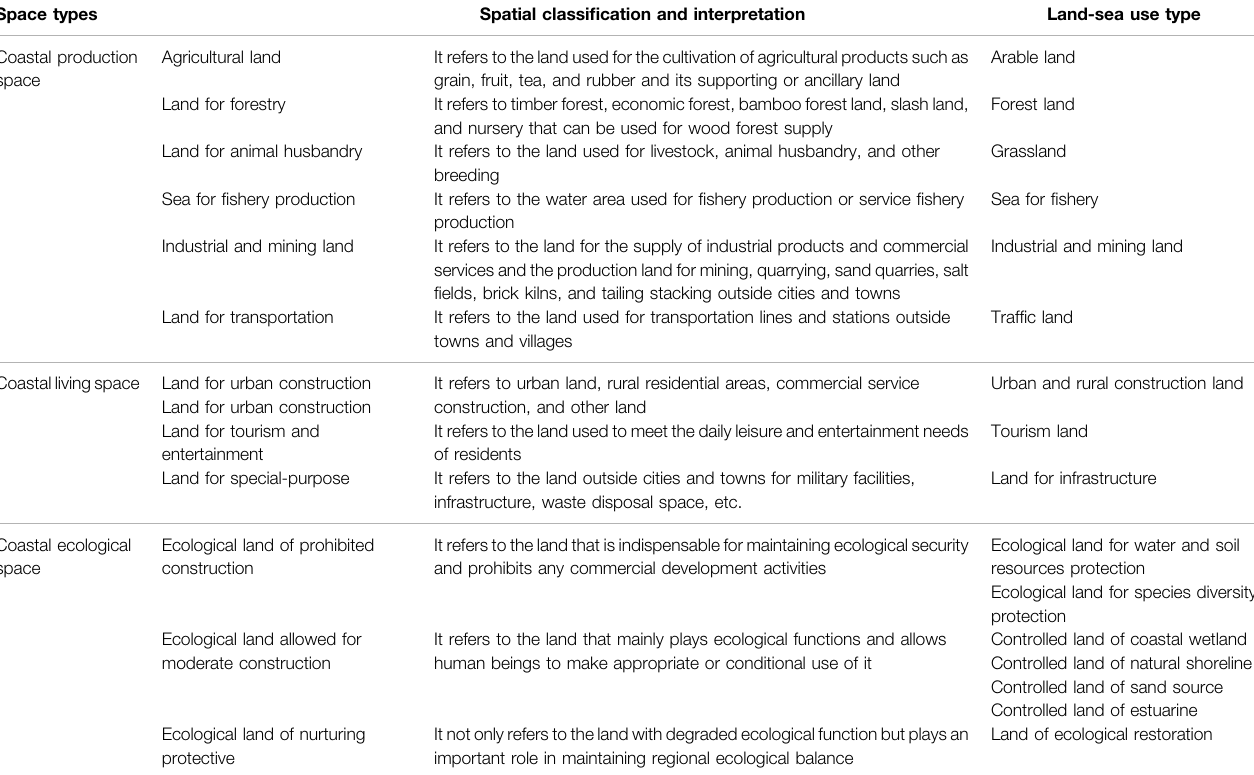
TABLE 1 | Classi fi cation of “ production-living-ecological spaces ” in the coastal zone and its controlled land types. Space